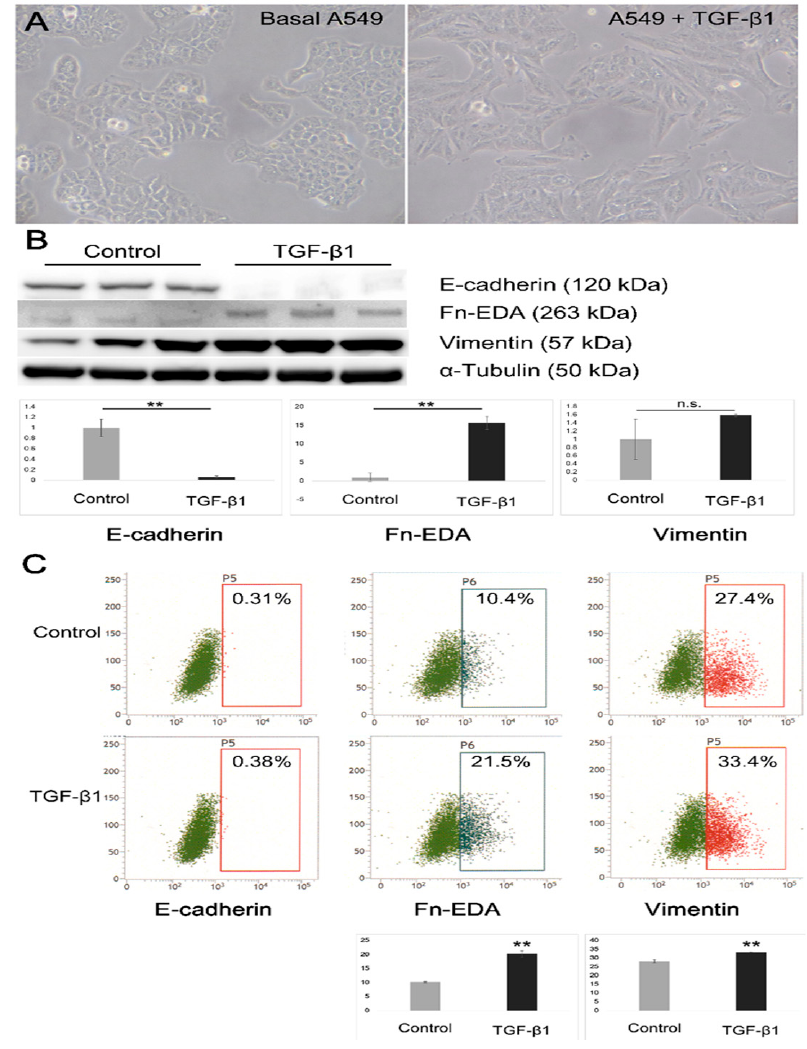
Figure 1. Morphological changes and expression changes in epithelial-to-mesenchymal transition (EMT)-related markers of A549 cells. ( A ) A549 cells were cultured in 6-well plates and treated with 10 ng/mL TGF- β 1 in DMEM/0.1% BSA (serum-free medium) for 48 h. In the presence of TGF- β 1, A549 cells changed from a pebble-like shape with clear cell–cell adhesion to a fibroblast-like spindle shape with decreased cell–cell contacts (magnification of 200 × ). ( B ) Western blot results show a decrease in E-cadherin expression and an increased extra domain A-containing cellular fibronectin (Fn-EDA). ( C ) Flow cytometry (FCM) analyses of cell surface expression of E-cadherin, Fn-EDA and vimentin. Control: the cells were mock-treated with serum-free medium. Images are representative of three independent experiments. **, p < 0.01.